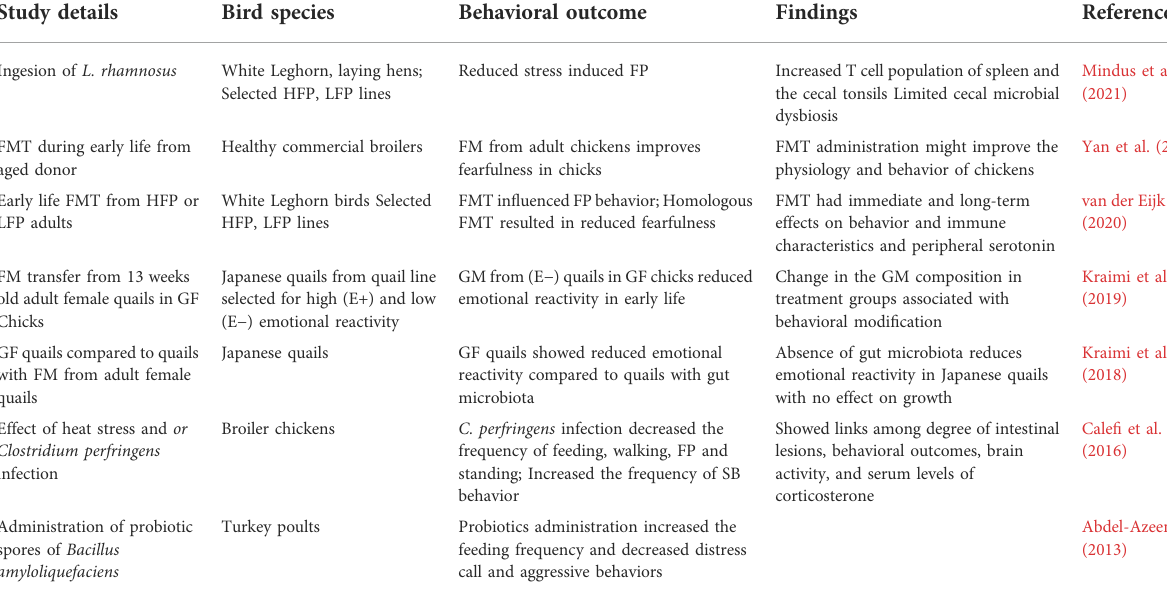
TABLE 1 Studies investigating effects of gut microbiota interventions on bird